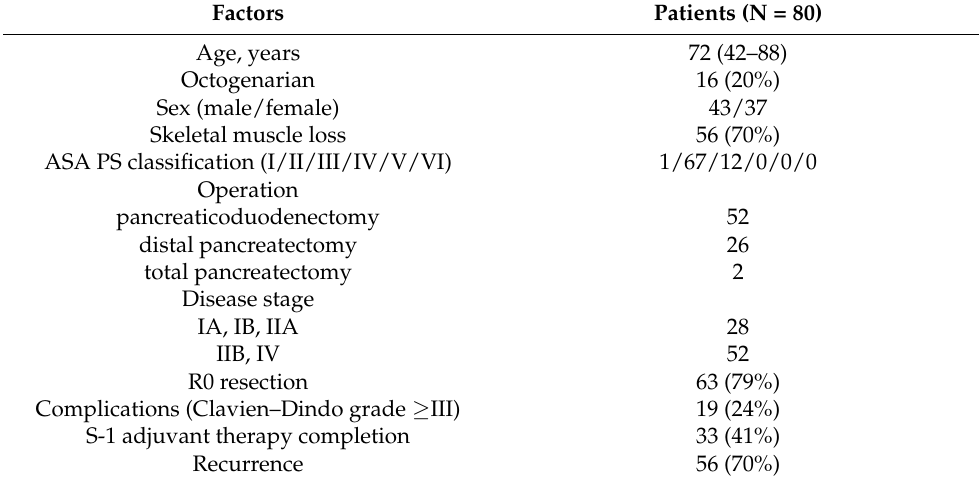
Table 1. Patient